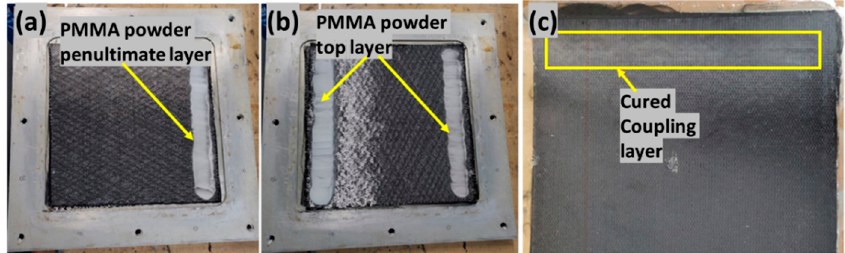
Figure 3. Powder applied on ( a ) penultimate layer, ( b ) outer adherend, ( c ) EP laminate with coupling layer.